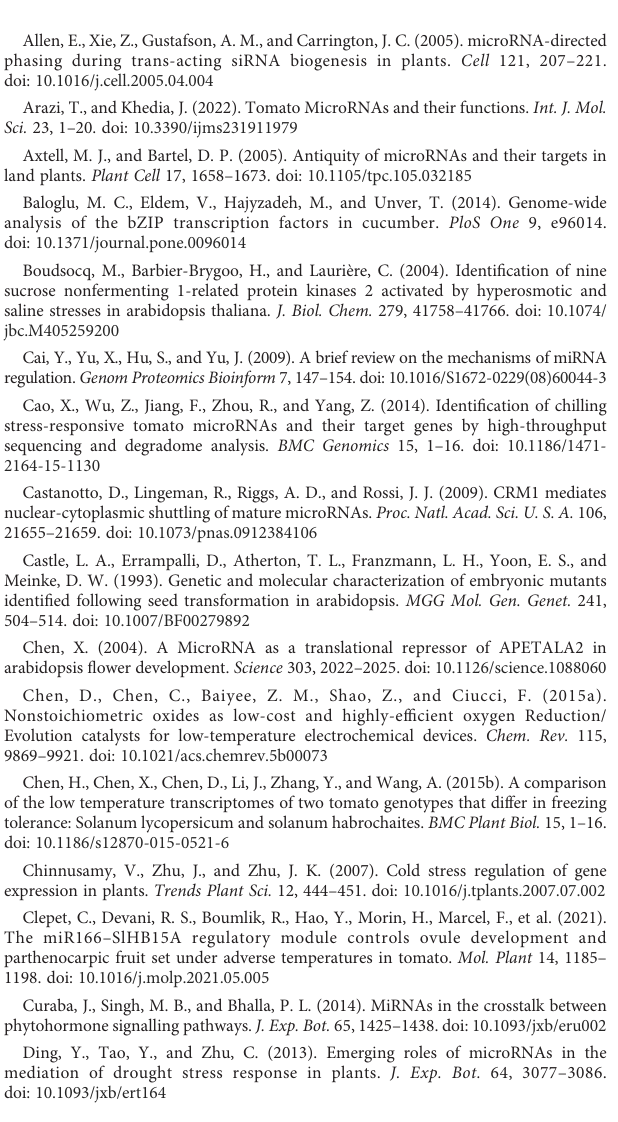
All primers used for quantitative